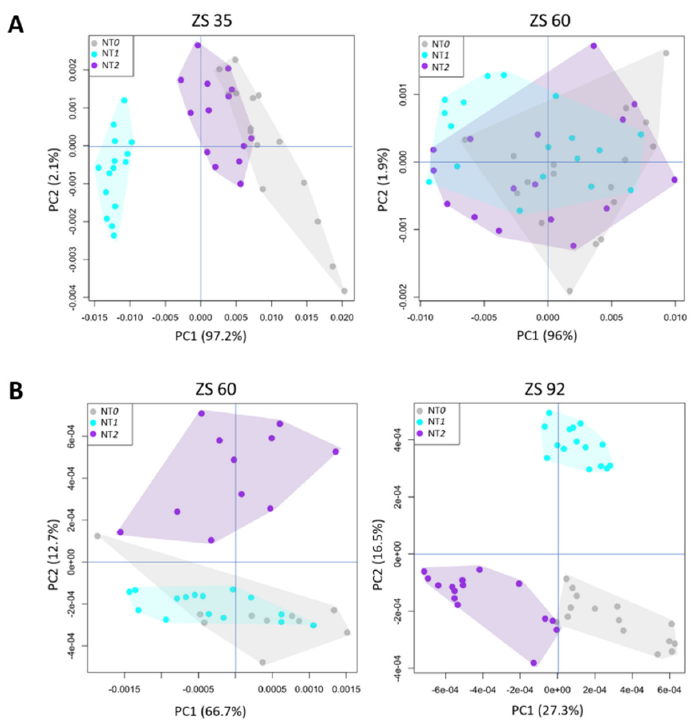
Figure 7. PCA scores plots of the spectral data of durum wheat leaves and caryopses grown on no-tillage soil, fertilized with 90 kg N ha − 1 (NT 1 ) and 180 kg N ha − 1 (NT 2 ): ( A ) durum wheat leaves (l-NT 0 , grey, l-NT 1 , light blue, and l-NT 2 , violet) at ZS 35 and ZS 60 sampling times, and ( B ) durum wheat caryopses (c-NT 0 , grey, c-NT 1 , light blue, and c-NT 2 , violet) at ZS 60 and ZS 92 sampling times.